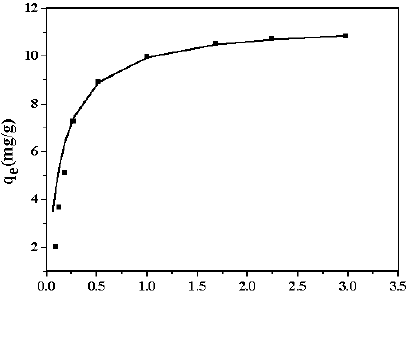
Figure 2. Adsorption isotherms of Zn 2+ on nano-TiO temperature = 298 K.